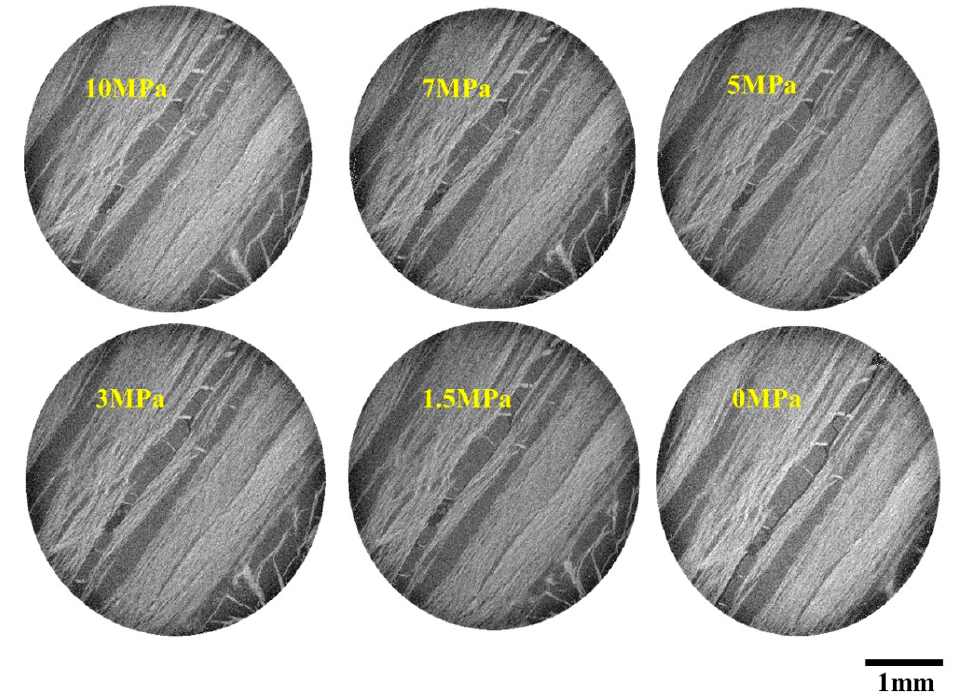
Figure 6. The 2D images of the same position in the unloading stage of the first cycle.